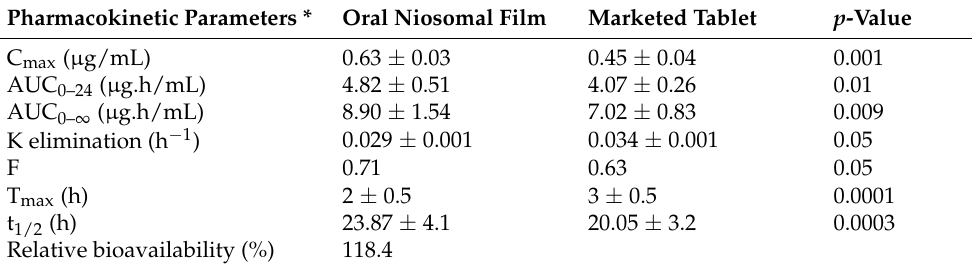
Table 8. Assessment of stability parameters; thickness and weight of tadalafil-loaded oral niosomal film.